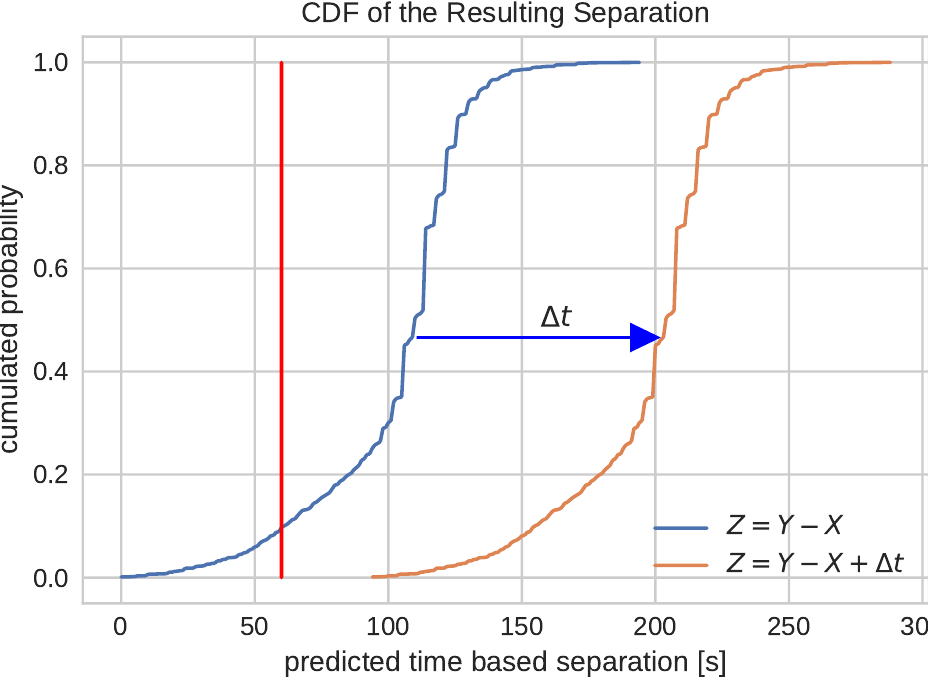
Figure 12. The predicted time-based separation between leader and follower (blue curve) will lead to a separation infringement (vertical red line) with probability of 0.1. The fol- lower has to lose 84 seconds to reduce the probability below 10 − 4 (orange